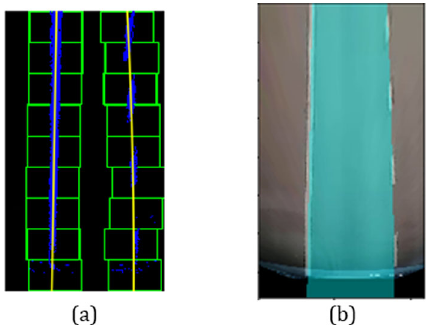
Figure 8. (a) Lane line fitted by polynomial curve, (b) Filled polynomial region.